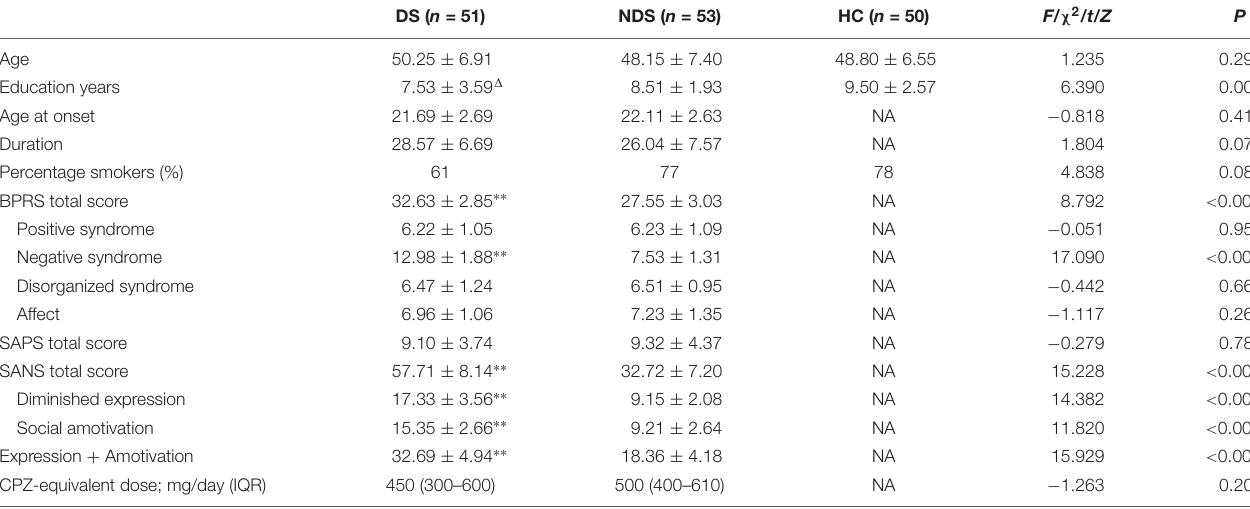
TABLE 1 | Demographics and characteristics for deficit schizophrenia (DS), non-deficit schizophrenia (NDS), and healthy subjects (HC) groups. DS ( n = 51) NDS ( n = 53) HC ( n = 50) F/ χ 2 /t/Z P Age